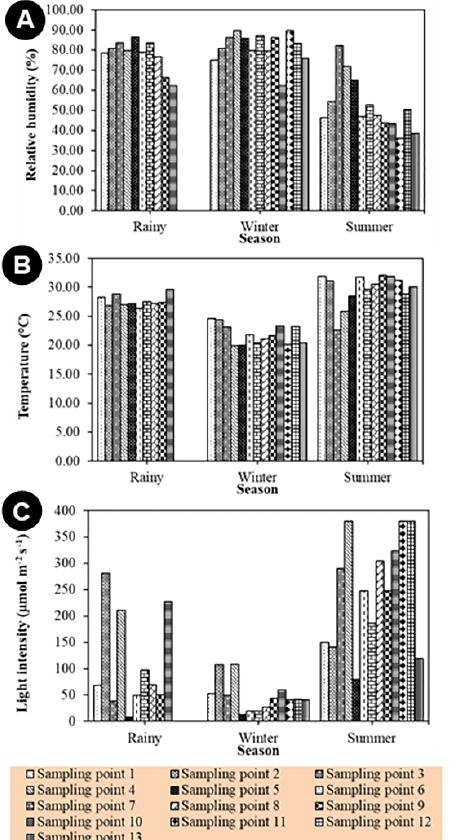
Figure 2 Data for environmental factors for ( A ) relative humidity, ( B ) temperature, and ( C ) light intensity in the rainy, winter, and summer seasons from the values of 10, 13, and 13 sampling point,